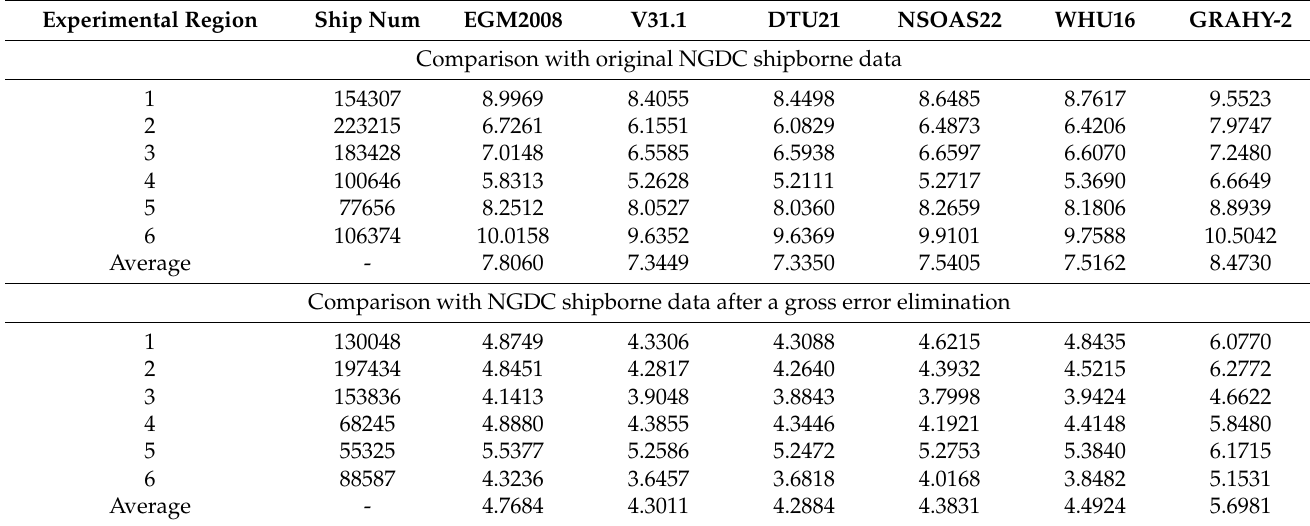
Table 10. Statistics of difference between shipborne measurements and typical gravity models (unit: mGal): Region 1, North Pacific; Region 2, South Pacific; Region 3, Mid-Pacific; Region 4, Indian Ocean; Region 5, North Atlantic; Region 6, South Atlantic. (The upper table shows the original statistics, while the lower table shows the accuracy results after a gross error elimination of shipborne